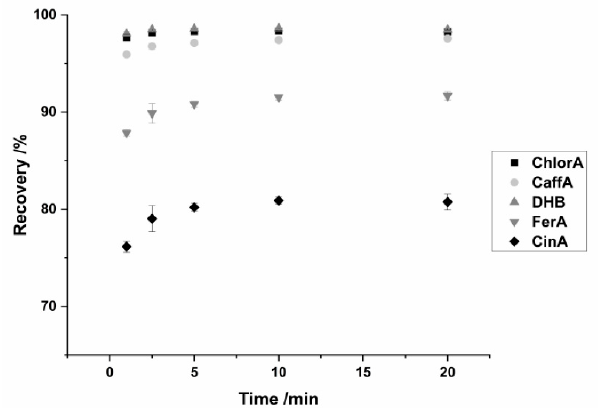
Figure 1. Analyte recovery results obtained from DSPE experiments with the poly(n-VIM/C 6 -bis- VIM) polymer with a monomer to crosslinker ratio of 11.50 to 1, by applying different extraction times. Standard deviations are given as error bars.